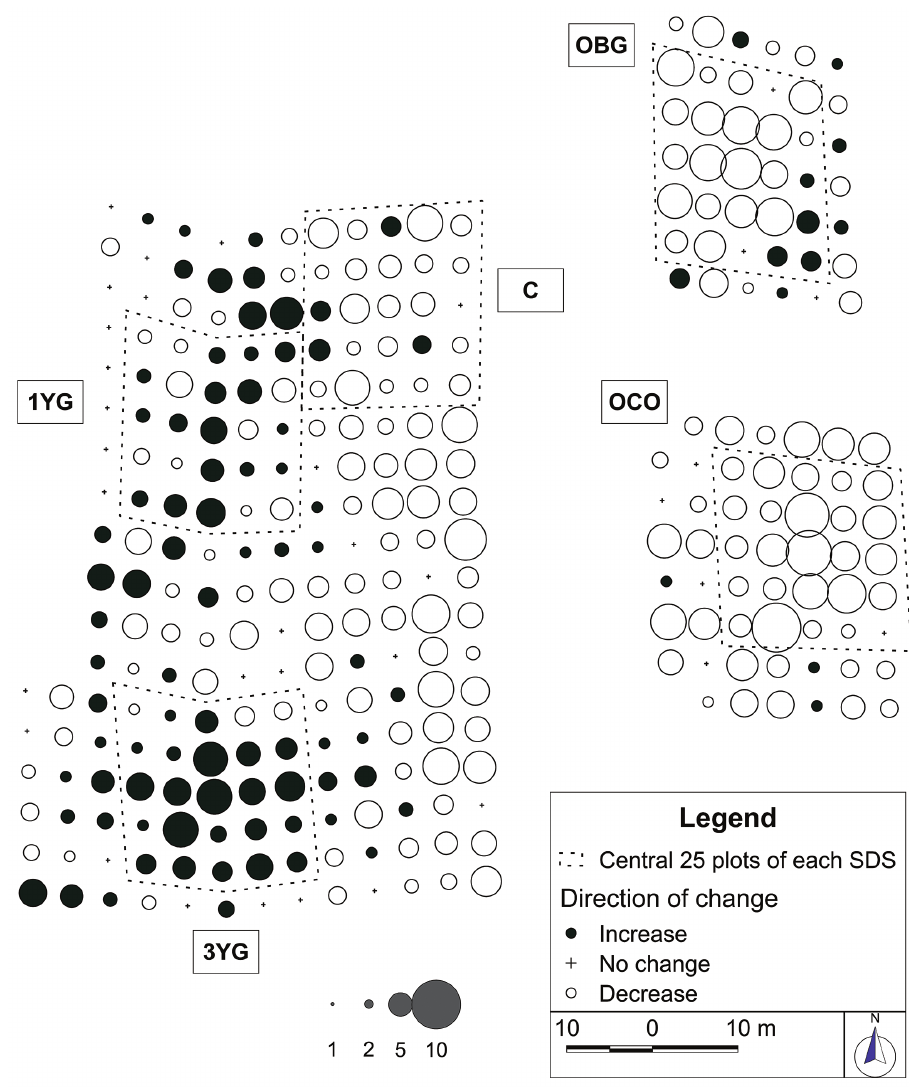
Figure 3. Changes in species richness between 1996 and 2013. Dotted lines indicate the borders of the samples representing the five stand dynamic situations (C, 1YG, 3YG, OBG, OCO). Number of extinction and colonization events and species turnover in the herba- ceous